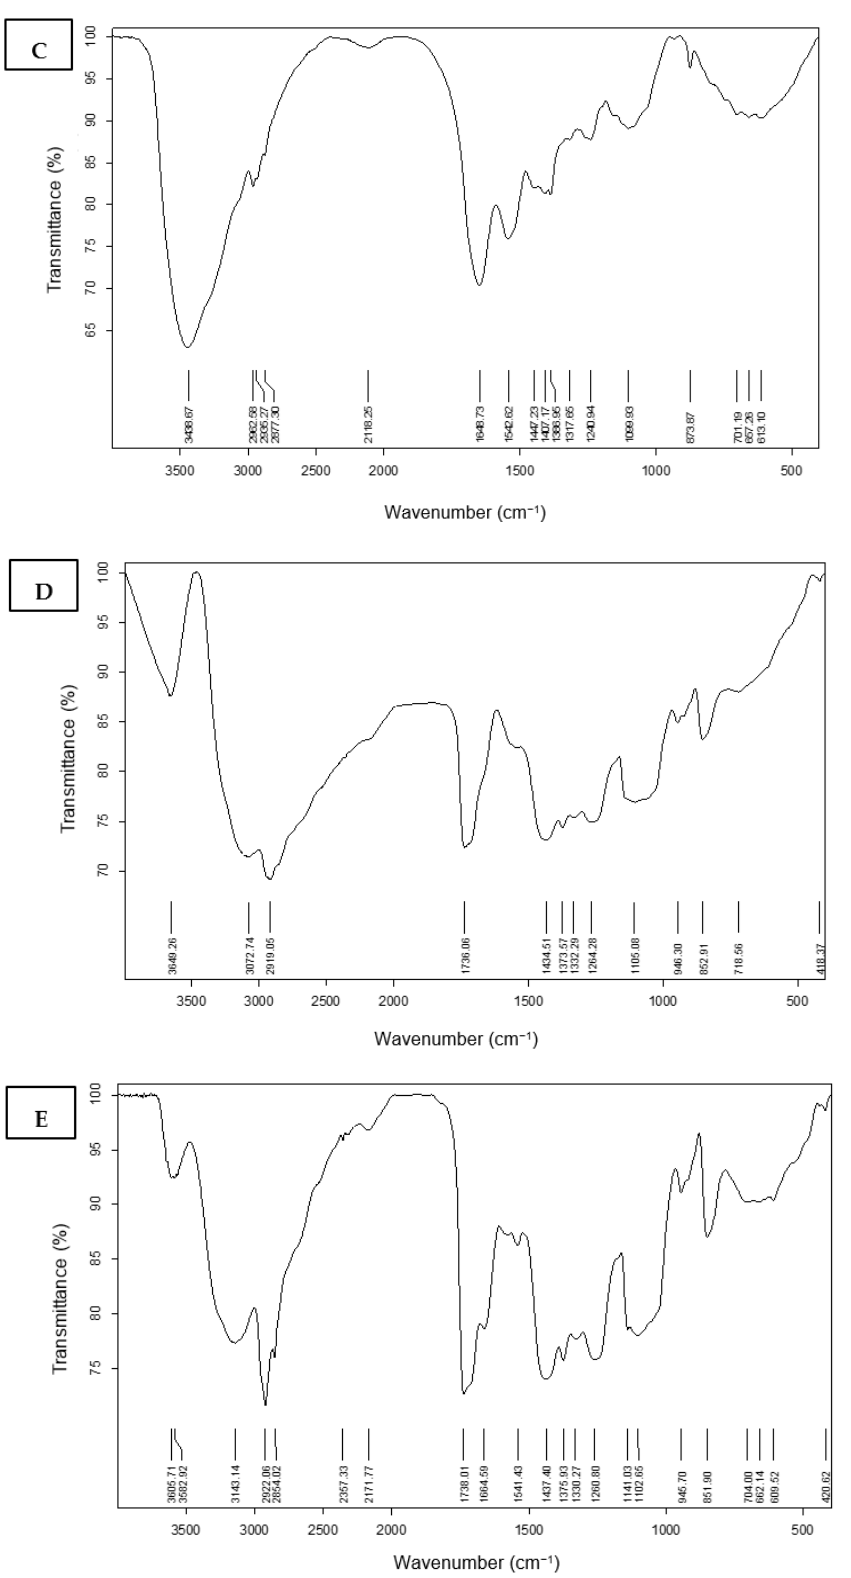
Figure 4. FT-IR of ( A ) PVA, ( B ) Ag nitrate, ( C ) snail mucus, ( D ) PVA/AgNPs-SM, ( E ) PVA/SM.